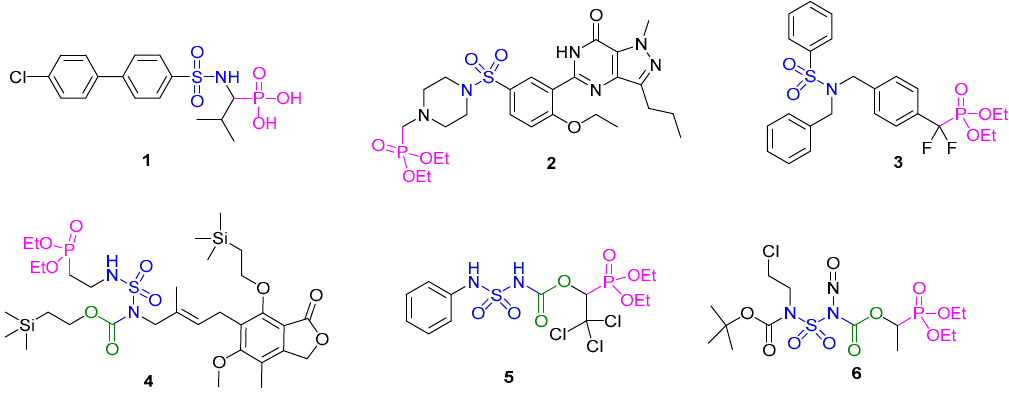
Figure 1. Structure of diverse sulfonamide and sulfamide derivatives containing a phosphonate-type group.